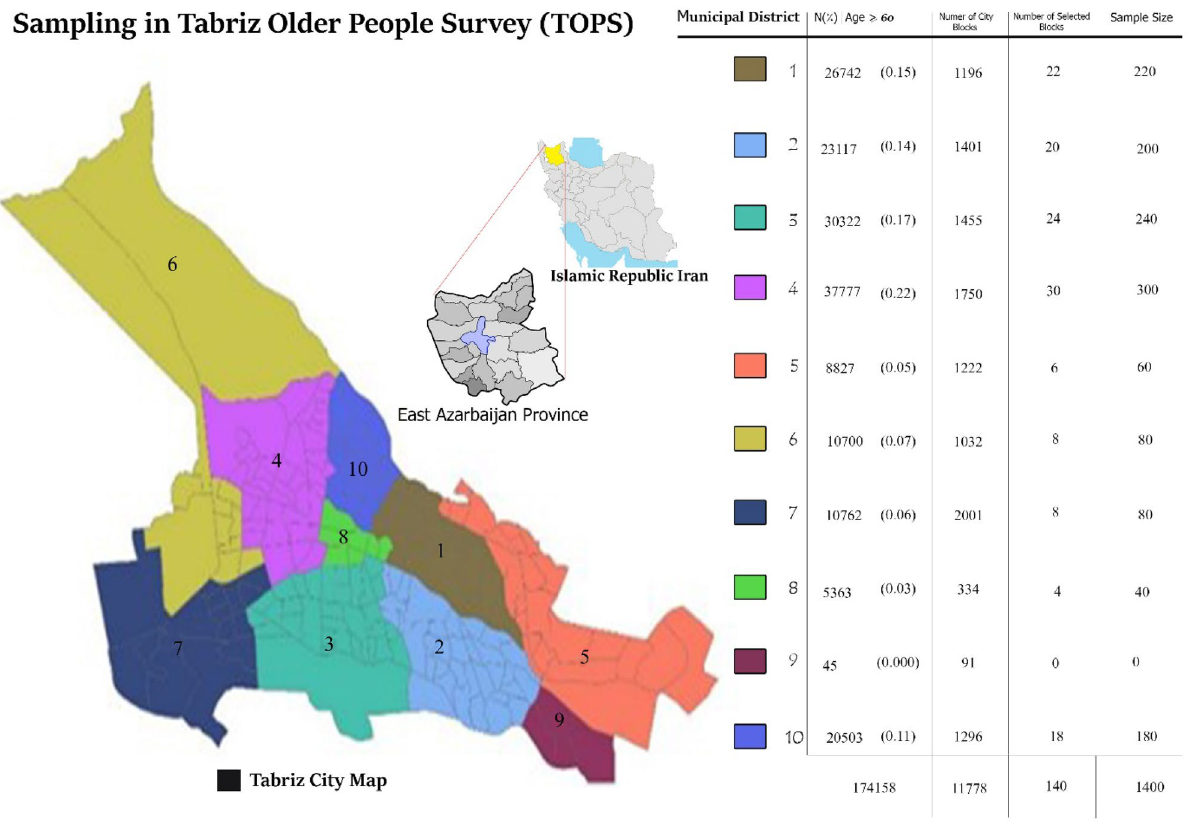
Figure 1. The number and proportion of older adults living in the municipal districts, the allocated sample size, and the number of blocks selected from each district of the ten municipal districts of Tabriz for the Tabriz Older People Health Survey (TOPS) study. (This figure was generated by Adobe Photoshop CC 14.0 and the maps were obtained from Wikipedia.). https:// en. wikip edia. org/ wiki/ Provi nces_ of_ Iran. https:// en. wikip edia. org/ wiki/ East_ Azerb aijan_ provi nce. https:// en. wikip edia. org/ wiki/ Tabriz_ Count y#/ media/ File: Tabriz_ county. PNG. https:// fa. wikip edia. org/ wiki/% D9% 85% D9% 86% D8% A7% D8% B7% D9% 82_% D8% B4% D9% 87% D8%